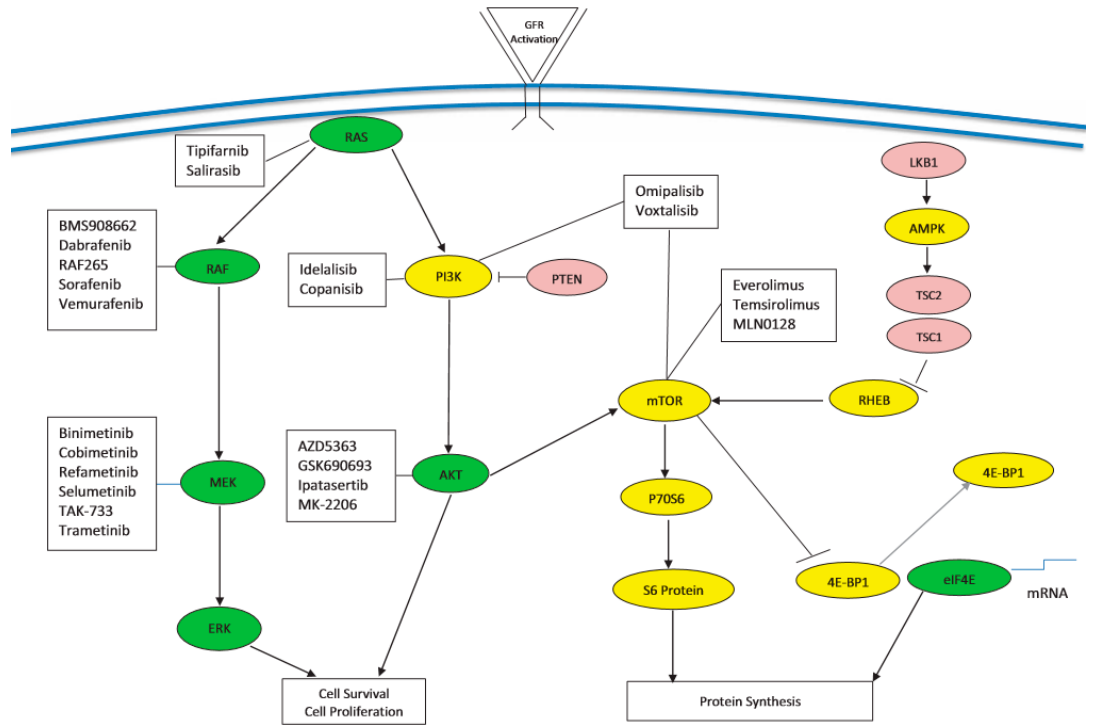
Figure 1. Illustration of Rat sarcoma (RAS) and phosphatidylinositiol 3-kinase (PI3K) Signaling. Redundant pathways allow for continued signaling leading to cellular proliferation and survival. A combinatorial approach with agents may overcome resistance.